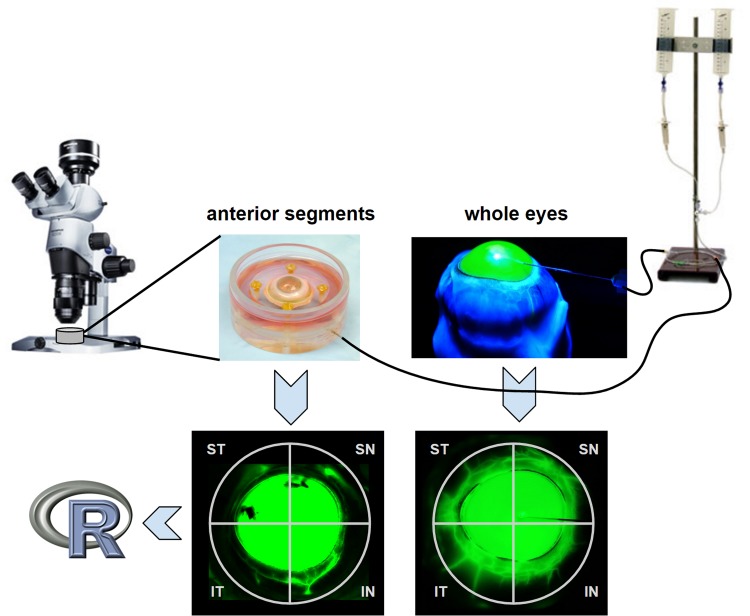
Imaging equipment and gravity perfusion of anterior segment culture (left) and whole eye mounts (right).Frontal view canalograms (bottom). Image data was processed using open source software environment, R. IN = inferonasal, SN = superonasal, ST = superotemporal, IT = inferotemporal quadrant. R = free software programming environment for statistical computing and graphics.